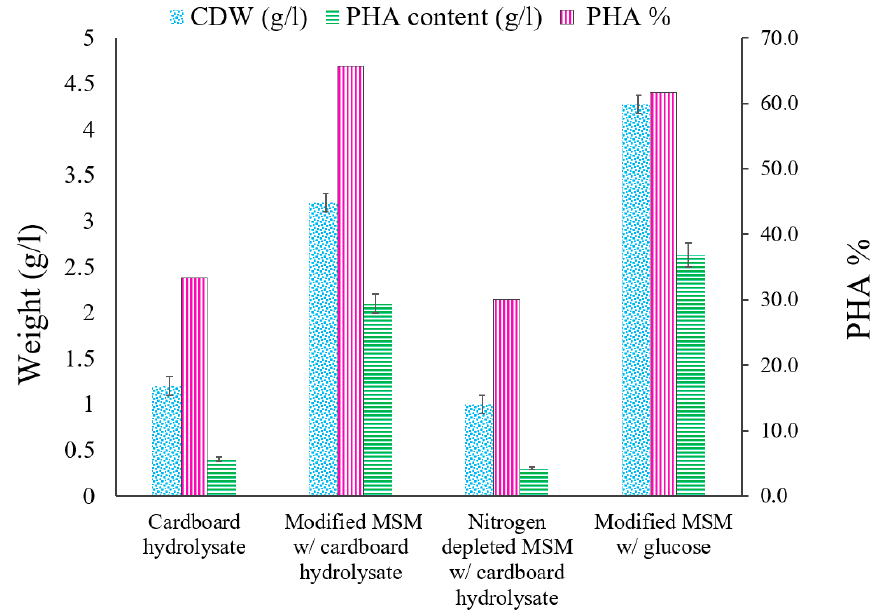
Figure 3. PHA content (g/L), cell dry weight (CDW) (g/L), and PHA productivity (%) in four differ- ent models.